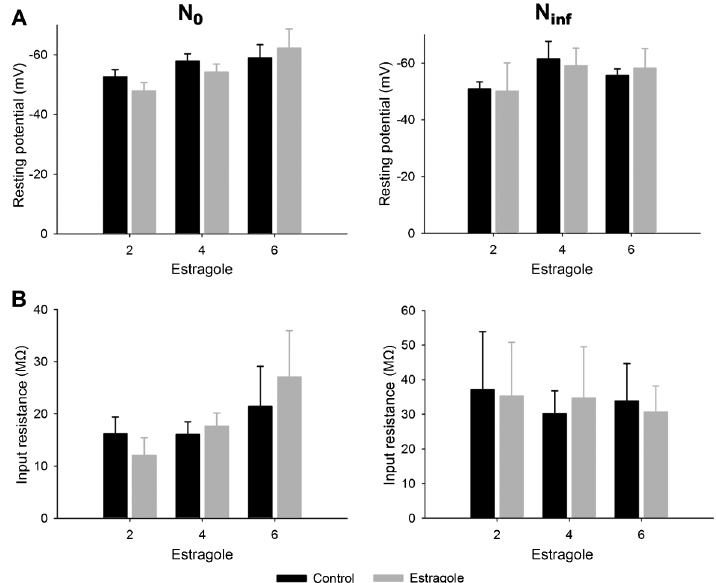
Figure 2. Effects of estragole on passive electrical properties of dorsal root ganglia neu- rons. Panels A and B report resting potential and input resistance, respectively, recorded in N 0 and N inf cells. At the estragole concentrations employed (2-6 mM), there were no significant differences between control and estragole treat- ment for either type of cells (P . 0.05, Student t - test). Data are reported as means±SE. The number of experiments was n=6-12 and n=4-7 for N 0 and N inf ,